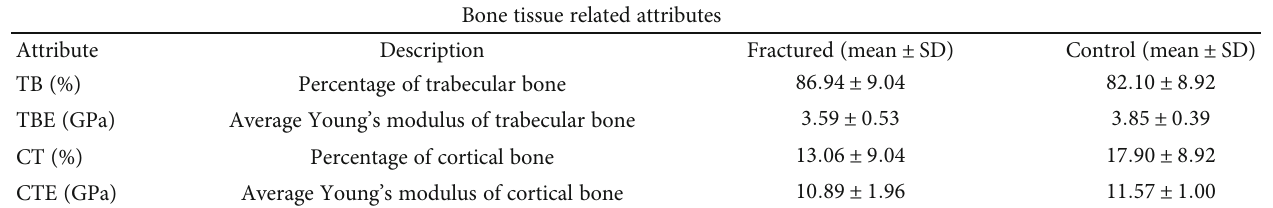
Table 4: Attributes related to the bone